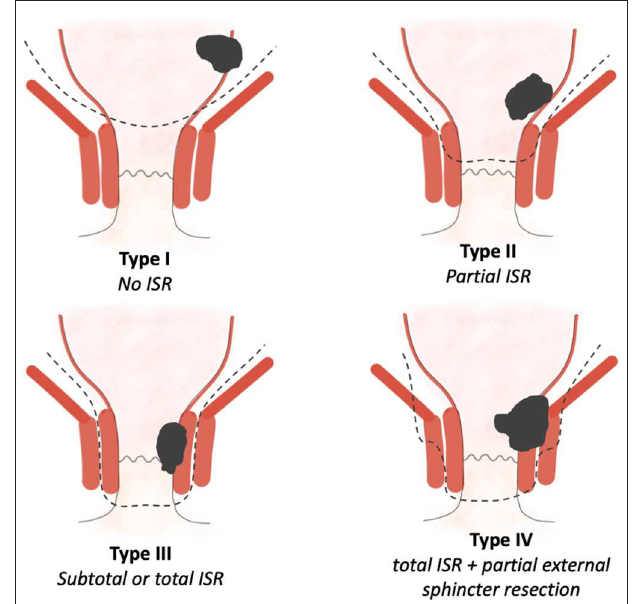
The rise of neoadjuvant treatments,